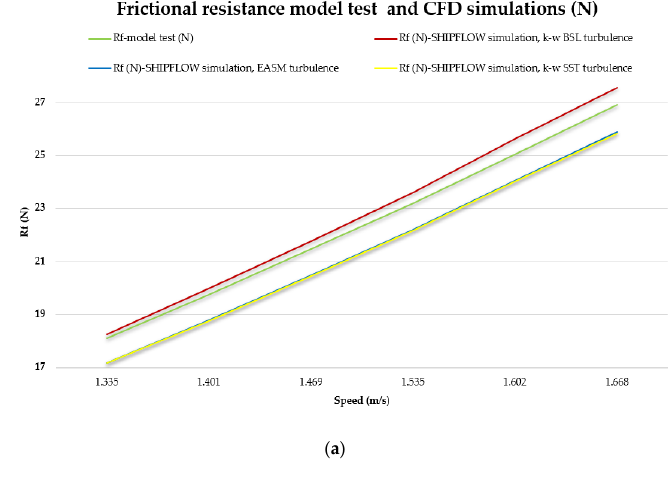
simulations and experimental tests is presented, while in Table 3, the percentage errors (computed following Equation (1)) between experimental tests and CFD simulations for the non-dimensional frictional resistance coefficient Cf (calculated according to ITTC 57), non-dimensional total resistance coefficient Ct and frictional resistance Rf (N) are pre- sented. From Figure 12 and the PE values presented in Tables 3–5, a good agreement between the model tests and CFD simulations for all parameters can be observed. model tests and CFD simulations for all parameters can be observed.